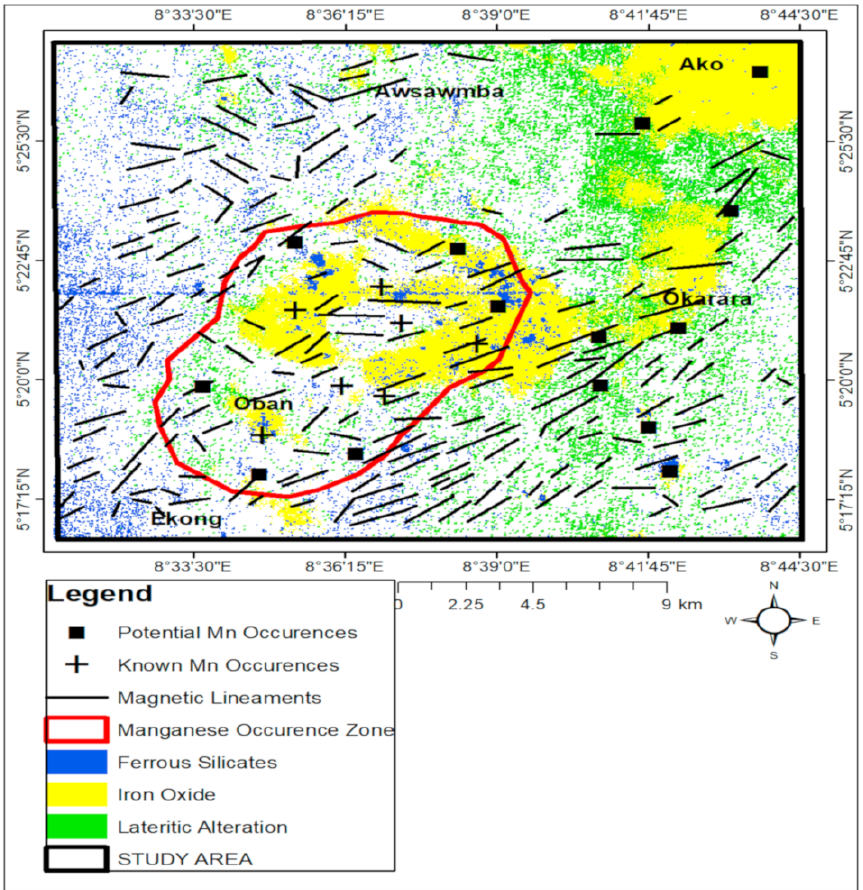
Figure 18. Potential minerals occurrence map with potential manganese zones in the study area (Modified from